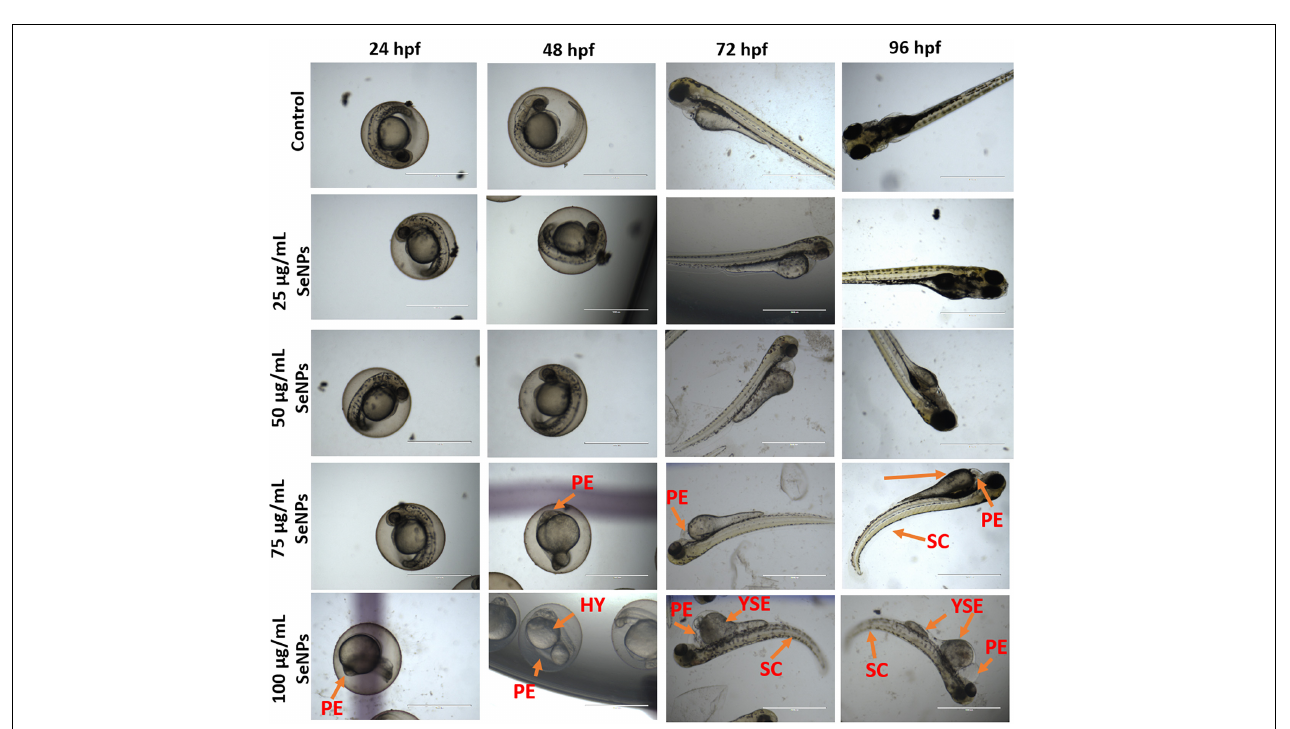
FIGURE 13 | Dose-dependent effect of SeNPs on caspase-3 level of (A) cancer cells and (B) normal cells. The experiments in the study were carried out three times, each time independently. The mean and SD of the triplicate research were calculated using the results from each experiment. The bar graphs with different letters within the particular analysis were significant ( p -value ≤ 0.05) by Tukey’s test.